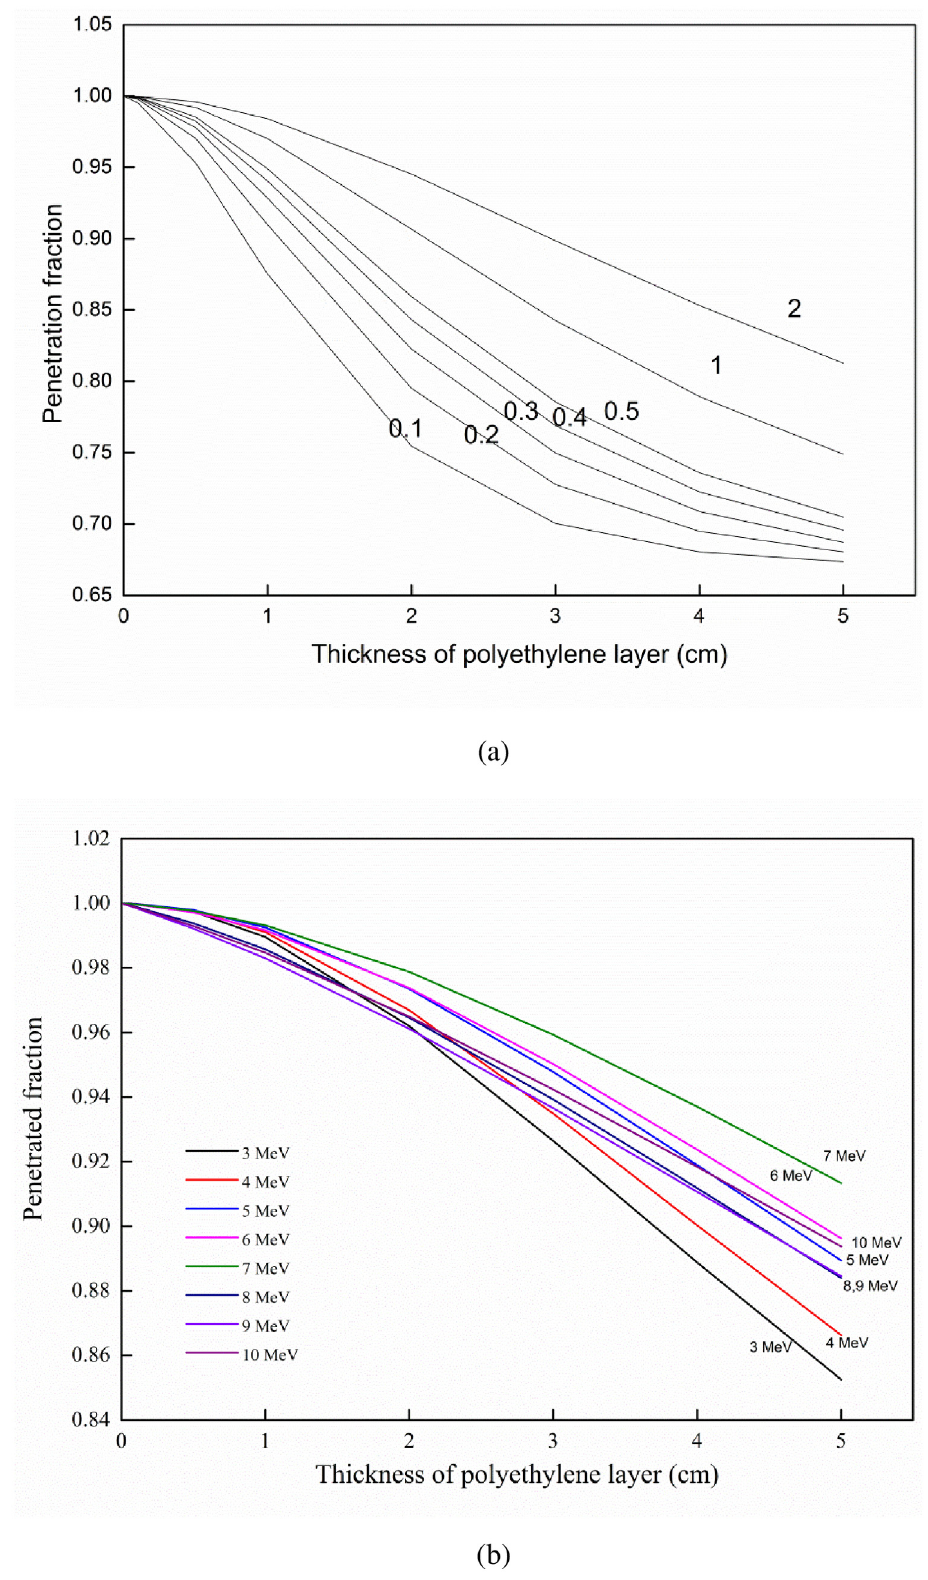
Fig 6. Penetration fraction of neutrons as a function of the PE layer thickness with energy as a parameter. (a) Energy range from 100 keV to 2 MeV. (b) Energy range from 3 to 10 MeV.